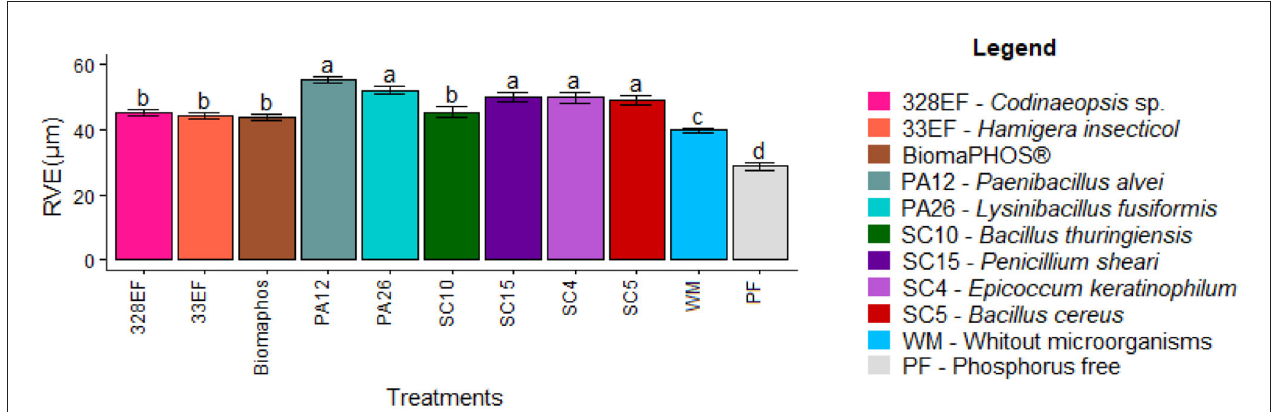
FIGURE 7 | Diameter of root vessel elements (RVE) in soybean plants ( G. max ) cultivated in nutrient solution providing calcium phosphate (CaHPO 4 ) as a phosphate source and inoculated with four bacterial strains and four fungal strains. Means followed by the same letter do not differ from one another according to the Scott-Knott test at 5%